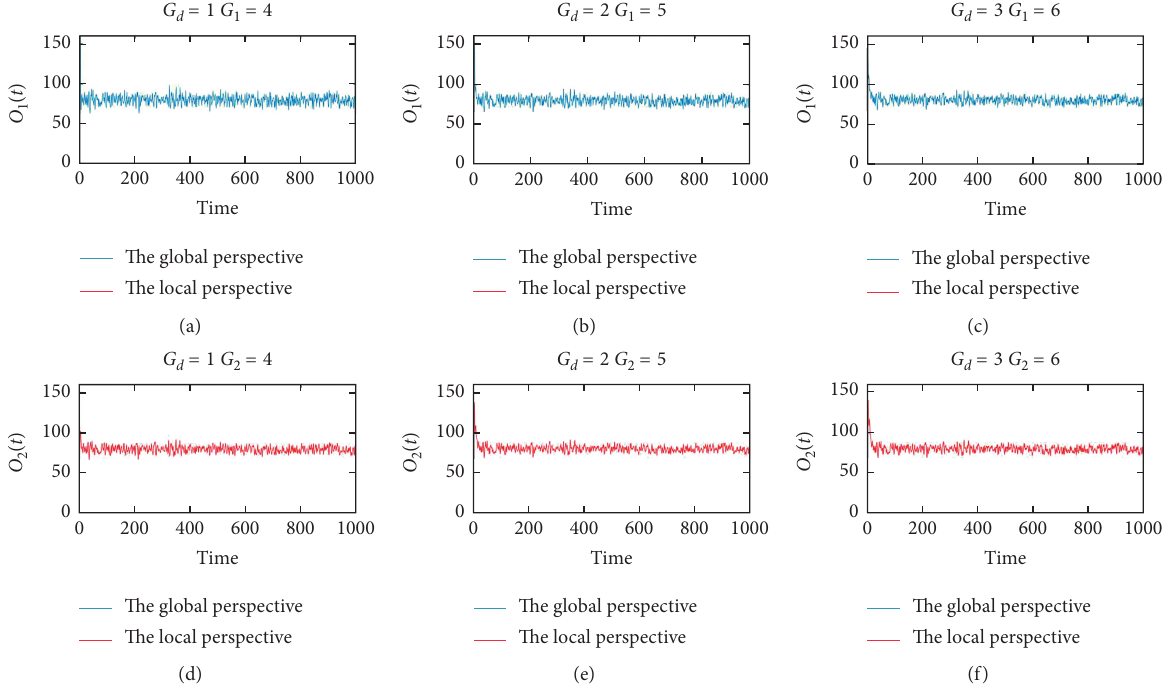
Figure 26: The production fluctuation under the scenario of random demand obeying normal distribution from different